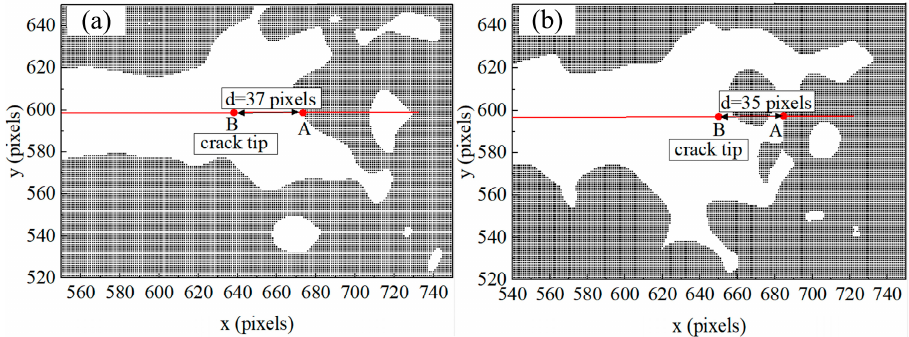
Figure 8. Finding the crack-tip x-coordinate according to the plastic zone: ( a ) specimen B1 a = 25.02 mm, ( b ) specimen W1 a = 24.48 mm.